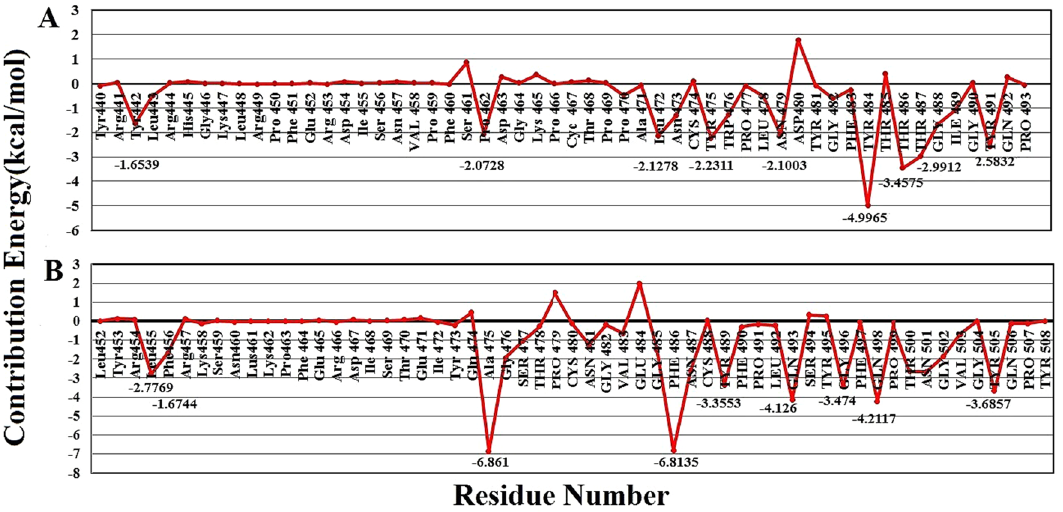
Figure 4. Free energy decomposition of the spike protein residues in the spike-ACE2 complex: ( A ) SARS-COV and ( B ) SARS-COV-2. The red graph shows binding free energy for each residue in the receptor-binding motif of the spike protein.